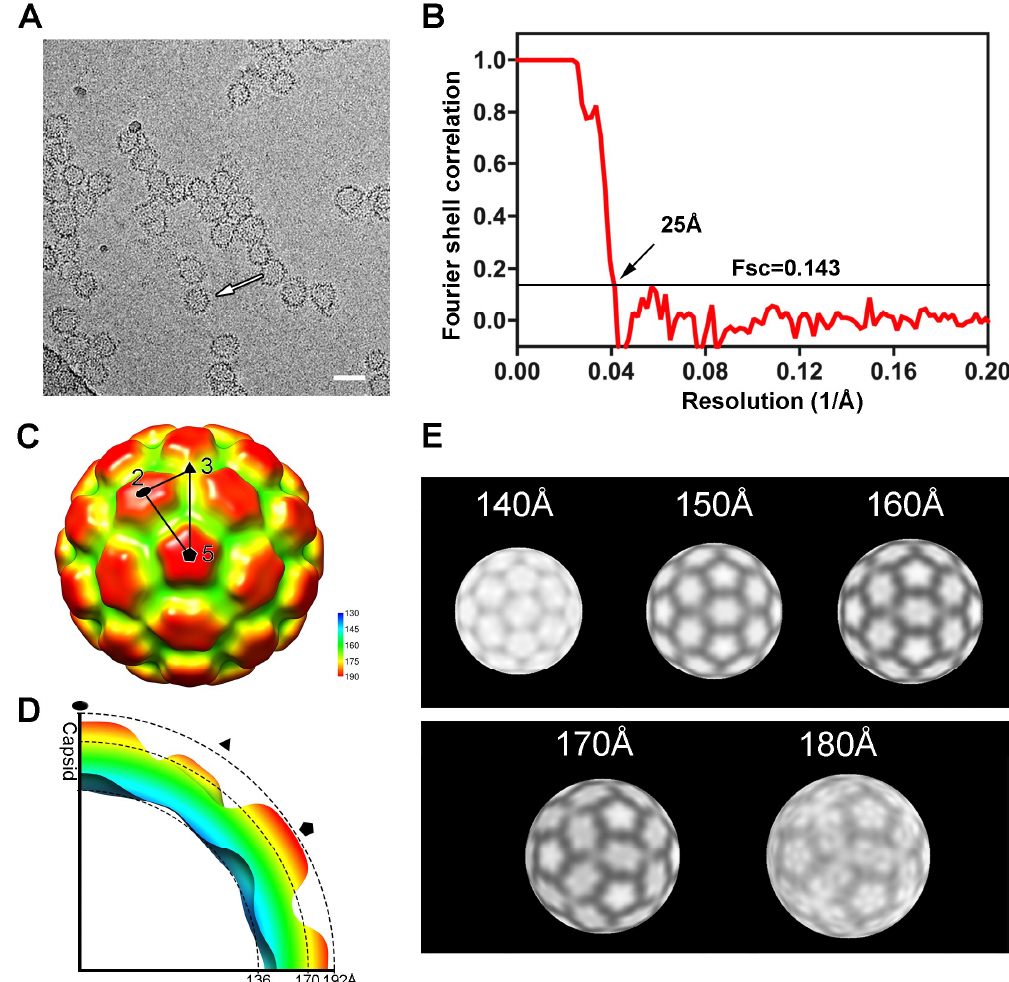
Figure 2. Cryo-electron micrography (Cryo-EM) and three-dimensional reconstruction of the CA N21C/A22C particle. ( A ) A representative cryo-electron micrograph of the CA N21C/A22C particle (white arrow). Scalebar is 50 nm. ( B ) Gold-standard Fourier Shell Correlation (FSC) curve for reconstruction of the N21C/A22C particle. ( C ) Surface rendering colored radially (blue to red) of the CA N21C/A22C cryo-EM density map viewed along a five-fold axis. The two-, three- and five-fold symmetry axes are indicated by the black ellipse, triangle and pentagon, respectively. An asymmetric unit (indicated by the big triangle) contains four CA subunits: One from a pentamer and three from a hexamer. ( D ) Density section of the N21C/A22C indicated in black dash lines with symmetry axes labeled. The inner and outer radii of capsid are 136 Å and 192 Å respectively, along the 2-fold axis. ( E ) Different radial projections of the map at the different radii (140 Å to 180 Å). The three hexamers show interactions in the range of 160Å to 180Å.